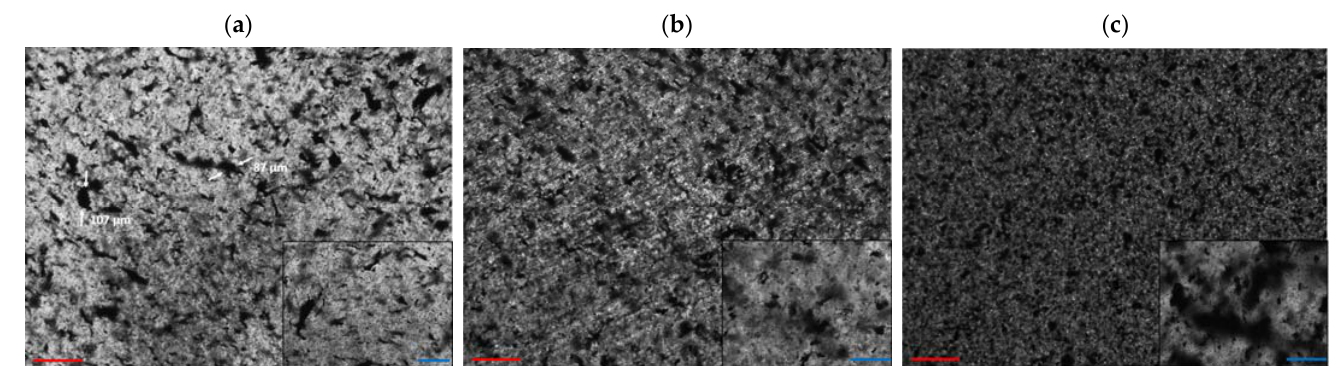
Figure 2. Optical microscopy (5x) of GNP based nanocomposites (red scale bar: 200 μ m, blue scale bar: 100 μ m). ( a ) HXE75 + 0.5 wt% G_T. ( b ) HXE75 + 0.5 wt% G_S. ( c ) HXE75 + 0.5 wt% G_FBM.